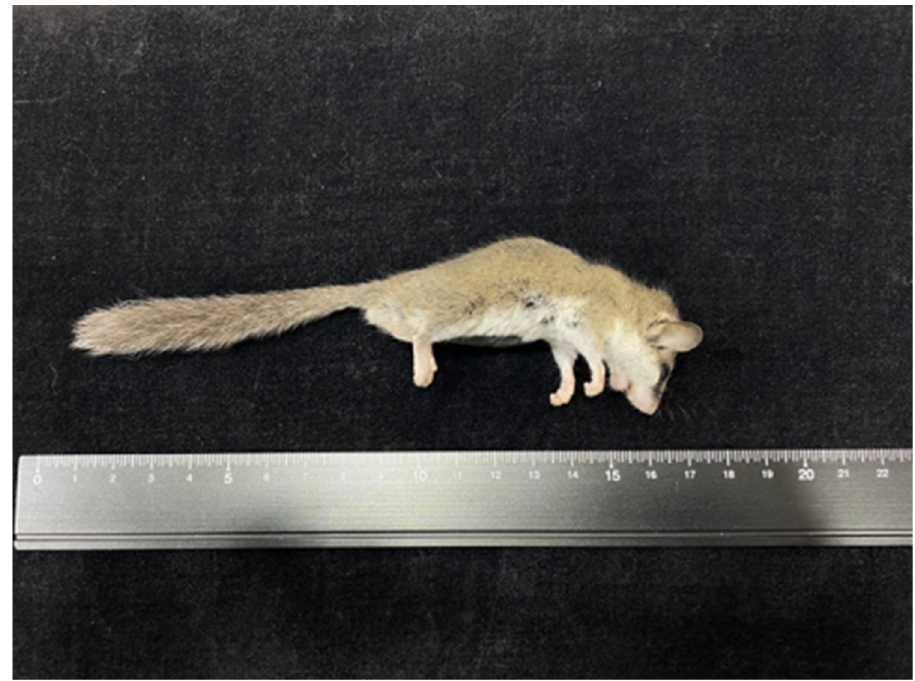
Figure 2. Gastric mast cell tumor, African dormouse. The dormouse is emaciated with abdominal retraction.